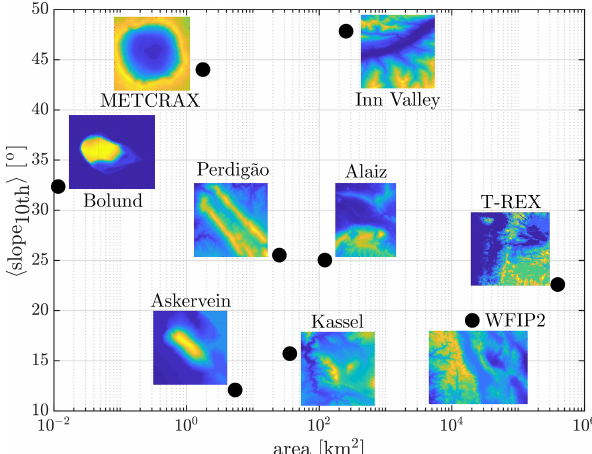
Figure 1. Illustration of the complexity of some atmospheric flow experiments as a function of their area of coverage. The complexity is in terms of the slope: the average 10th percentile of the highest slopes. The inserts besides the markers show contour maps of the relative elevation for each site, where blue and yellow colors repre- sent low and high elevations,